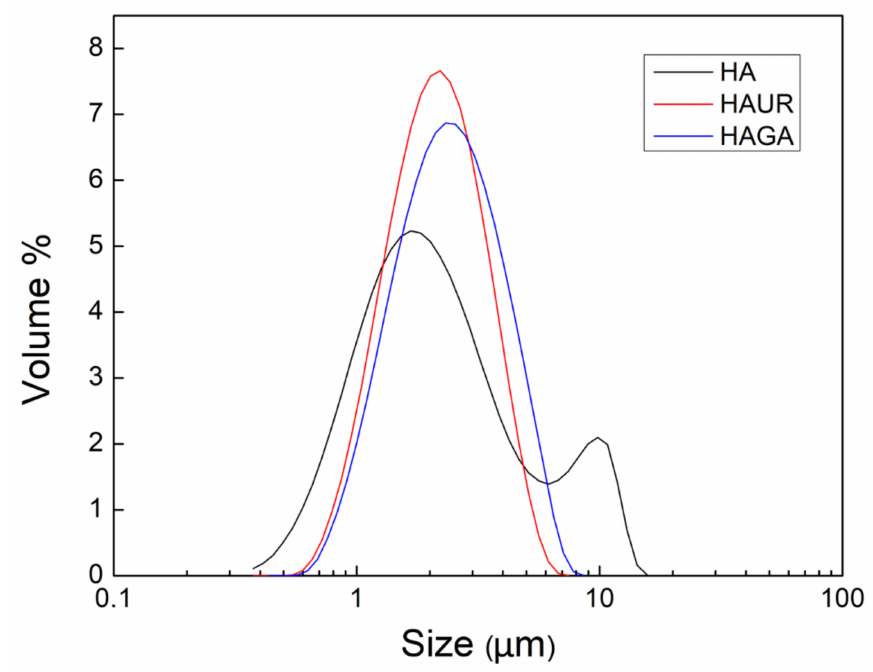
Figure 3. Size distribution of microparticles formed from native (HA) and crosslinked (HAUR and HAGA)